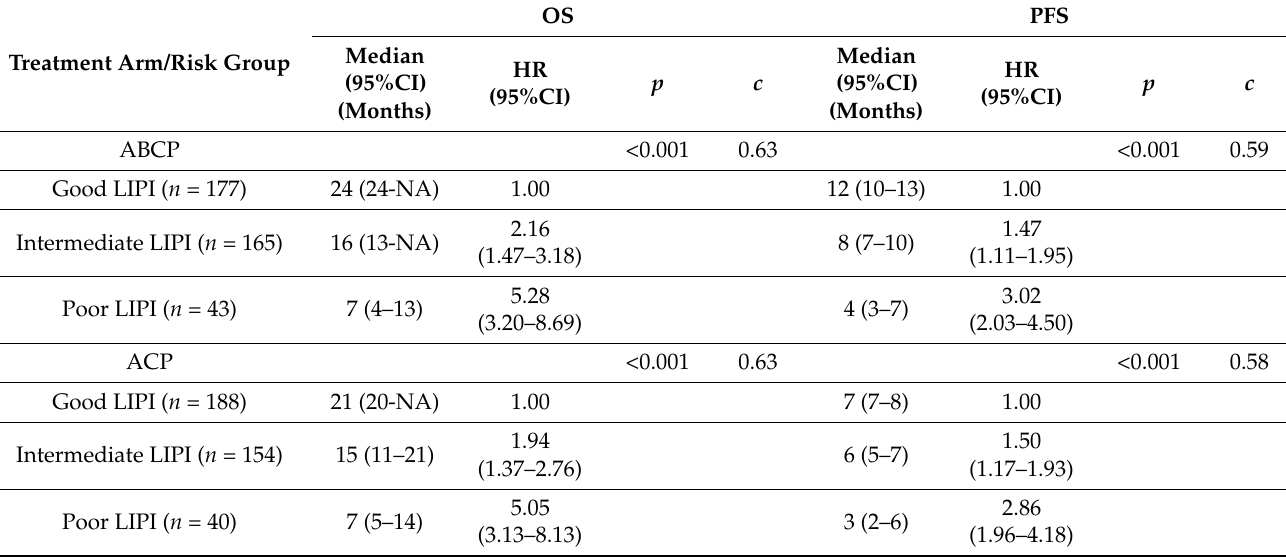
Table 1. Association between lung immune prognostic index (LIPI) and survival outcomes for patients randomized atezolizumab-bevacizumab-carboplatin-paclitaxel (ABCP) or atezolizumab-carboplatin-paclitaxel (ACP).